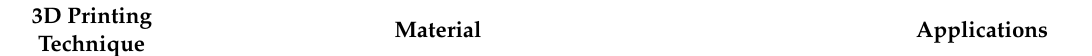
Table 2. 3D printing polymerics materials for robots with embedded